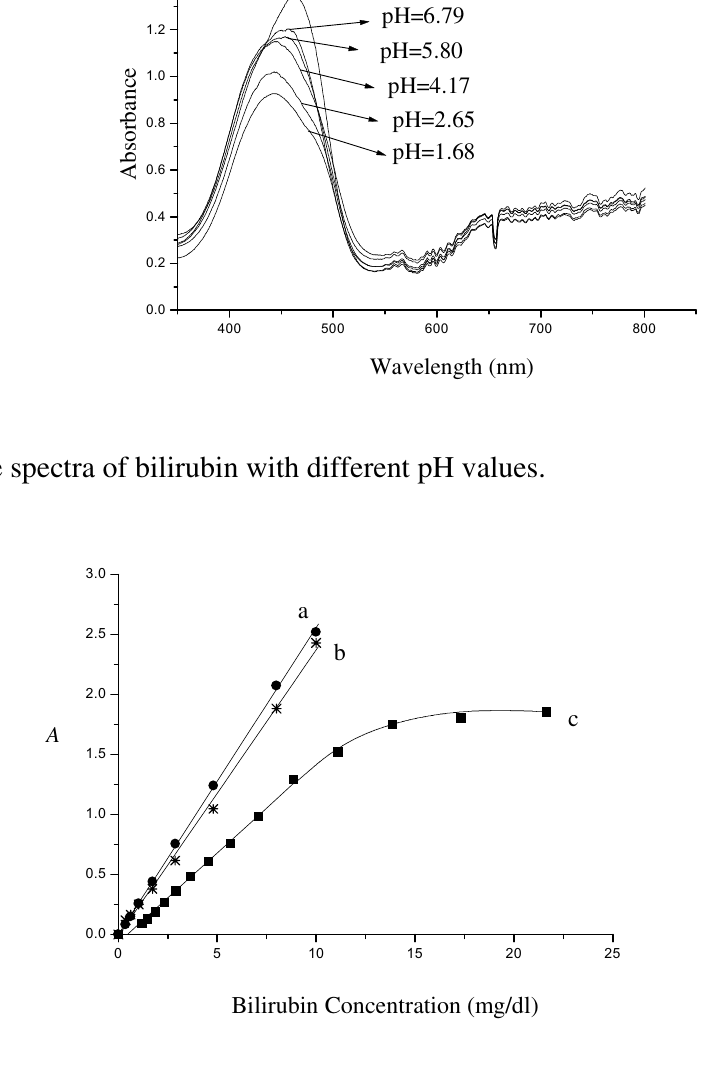
Figure 7. Comparison of the fiberoptic sensor response in bilirubin standard solution at pH 1.26 (curve a) and 6.21 (curve b) to that in bile mixture with HCl solution at pH 1.16 (curve